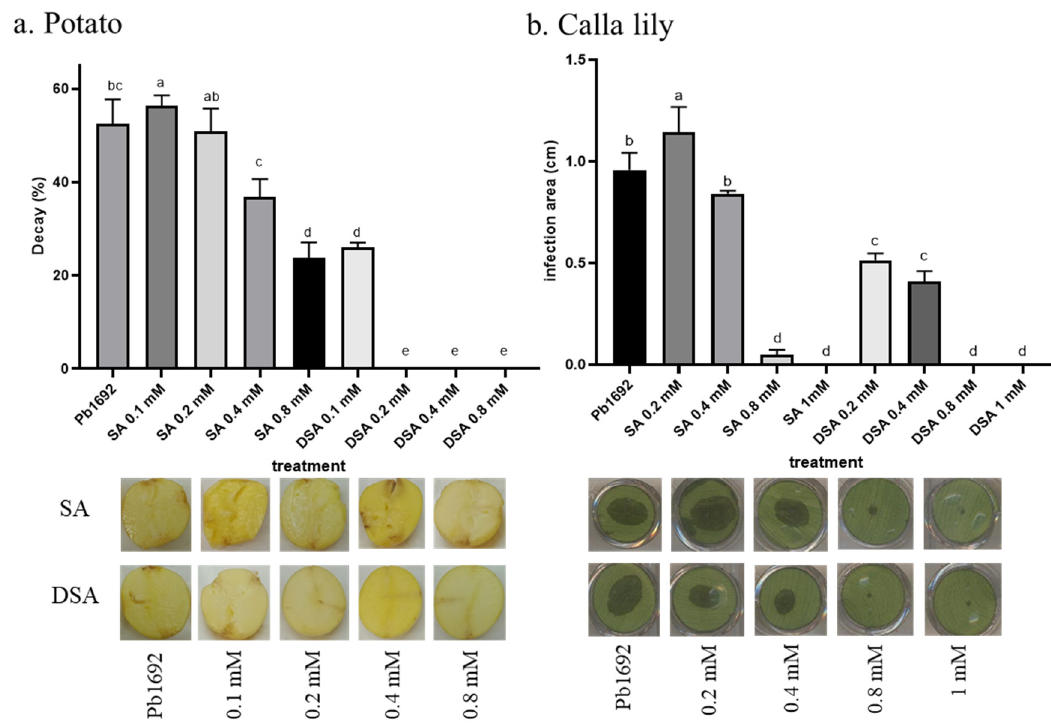
Figure 8. Effects of SA and DSA on the virulence of Pb1692 on ( a ) potato and ( b ) calla lily. Bacterial cultures of Pb1692 were exposed to DSA ans SA at 0.1–1.0 mM concentrations for 2 h prior to the inoculation of the hosts. Bacterial inoculum was diluted to 5 × 10 6 CFU mL − 1 for potato and 1 × 10 7 CFU mL − 1 for calla lily. Virulence was determined as the percentage of decayed tissue 24 h after inoculation of the calla lily leaves and 48 h after inoculation of the potato tubers. The results are presented as decay relative to the induced by the untreated (DDW) bacterial culture (controls). Data are means ± SE of 2 independent experiments with similar results, with 10 replicates (discs) for calla lily and 4 replicates (tubers) for potato in each experiment. Bars that are not labelled with the same letter are significantly different from each other ( p < 0.05; bar = SE). One-way ANOVA and post hoc Tukey-Kramer HSD tests were used to analyze differences. The analysis was performed using GraphPad Prism 8.0. Representative pictures are shown for infected potato tubers (bottom left) and infected calla lily leaf discs (bottom right).